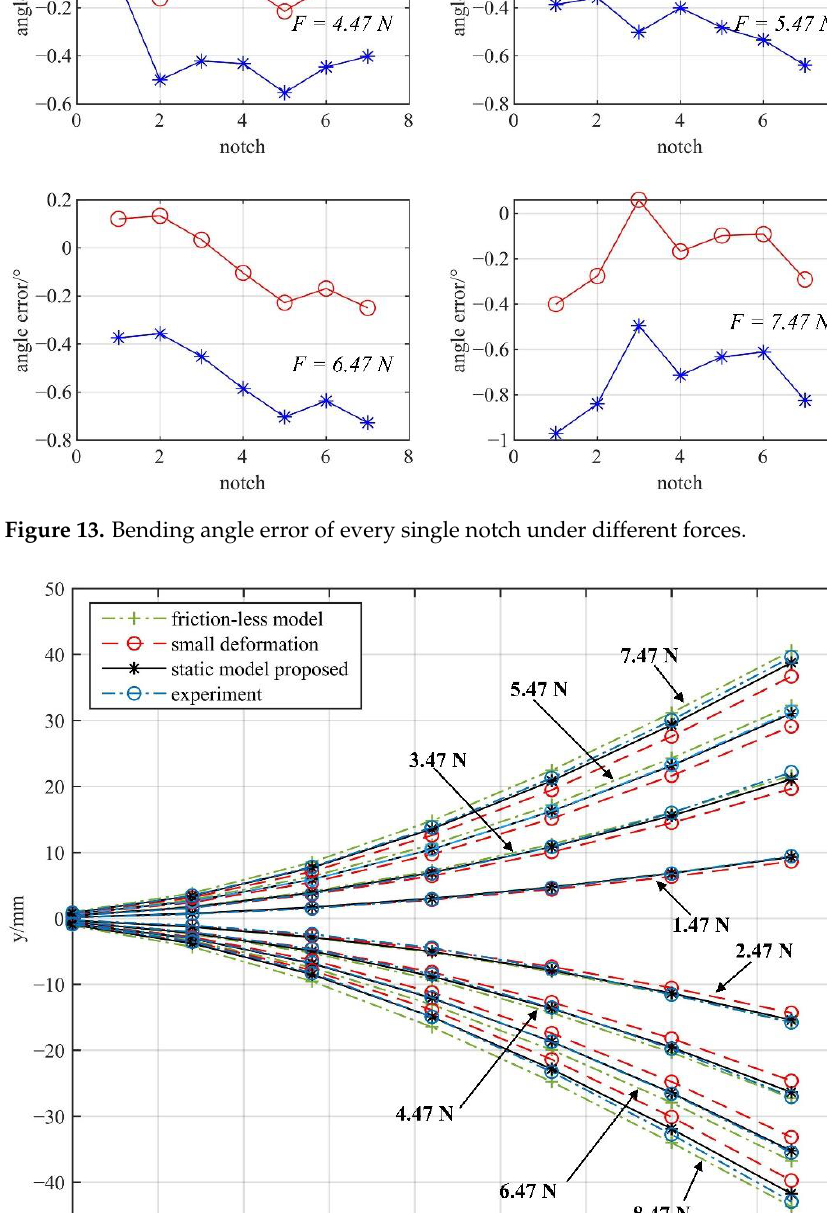
Machines 2022 , 10 , x FOR PEER REVIEW 15 of 17